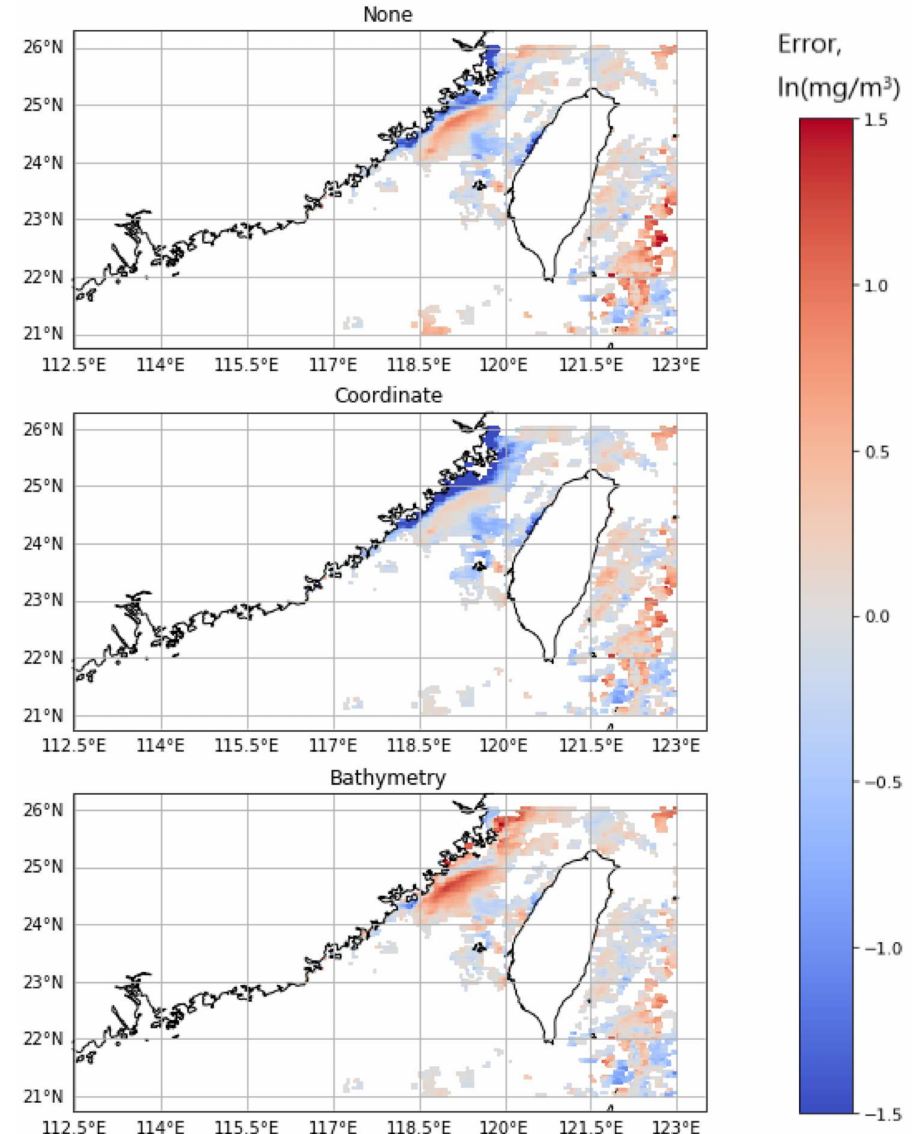
Figure 13. Error between ln ( Chl-a rec ) and ln ( Chl-a obs ) of the models in